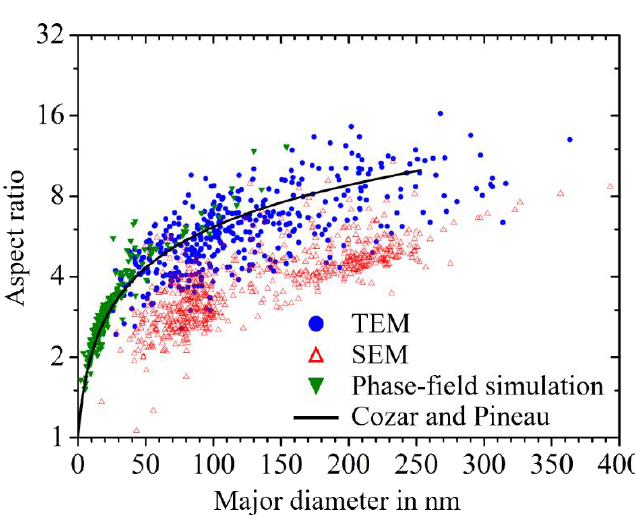
Figure 12. Plot of the aspect ratio from the elliptical site section of γ′′ particle (type [100] and type [010]) as a function of the major diameter. Comparison of SEM results, TEM results, phase-field simulation results and the analytical model of Cozar and Pineau [36].